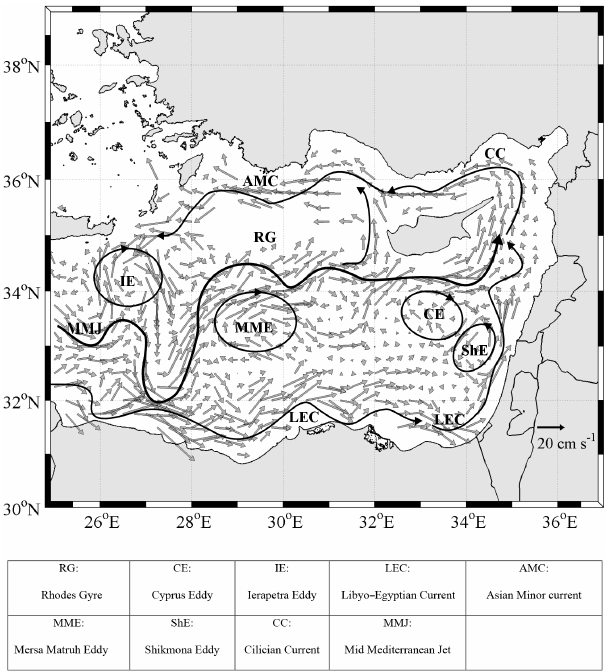
Fig. 5b. Mean absolute geostrophic velocities in the period 1992– 2010 (dark grey). Black lines emphasize the main currents and sub- basin eddies for which names are given in the table.